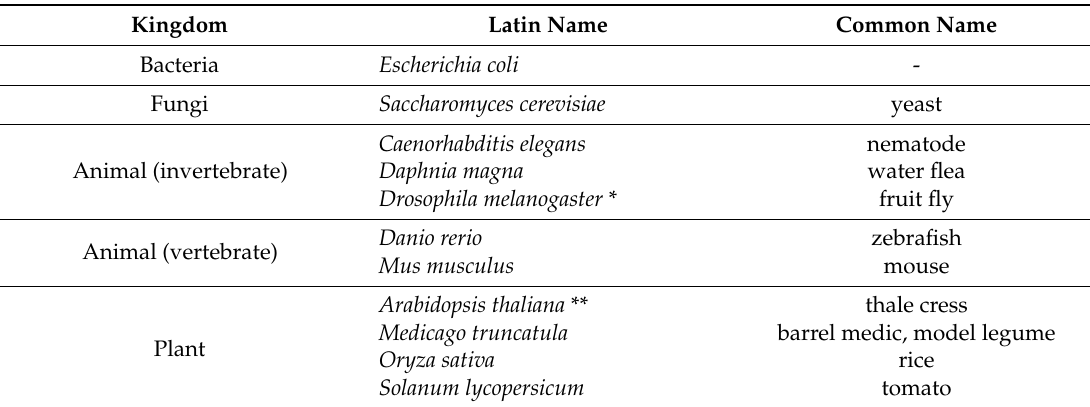
Table 1. Prioritized list of model organisms that the new MOM task group recommend for deep investigations of their